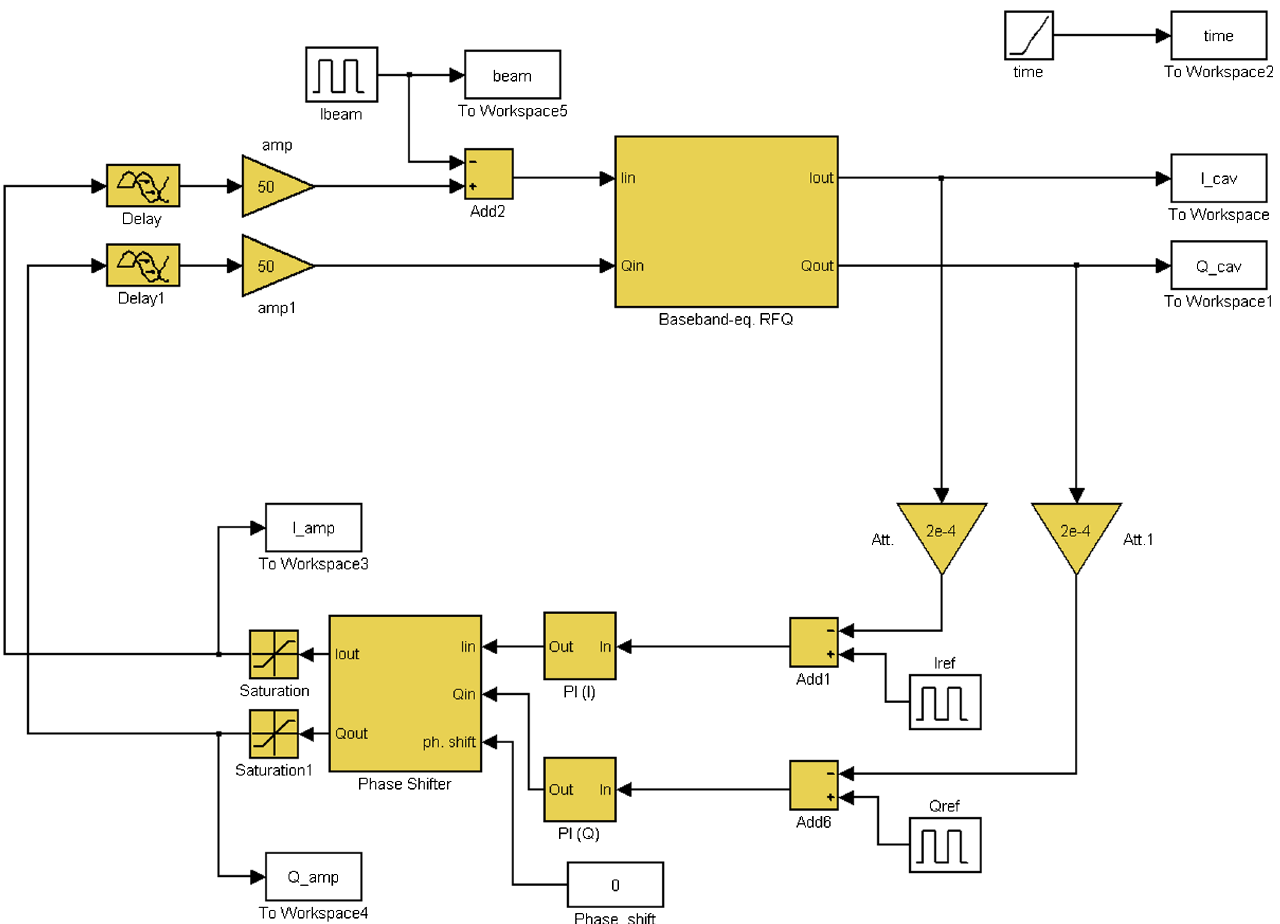
FIG. 9. Baseband-equivalent model of the feedback loop including the RFQ, the LLRF, and the rf amplifier; the model simulates the envelope of the signals in time domain with the advantage of significantly reducing the simulation time compared to the combined rf-baseband